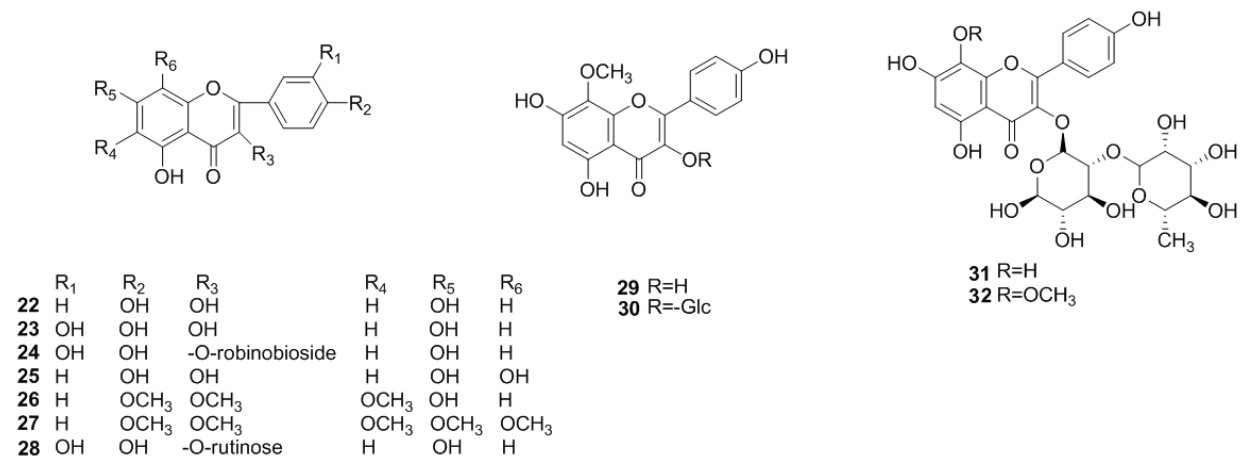
Figure 2. Chemical structures of flavonols in C. pinnatifida .